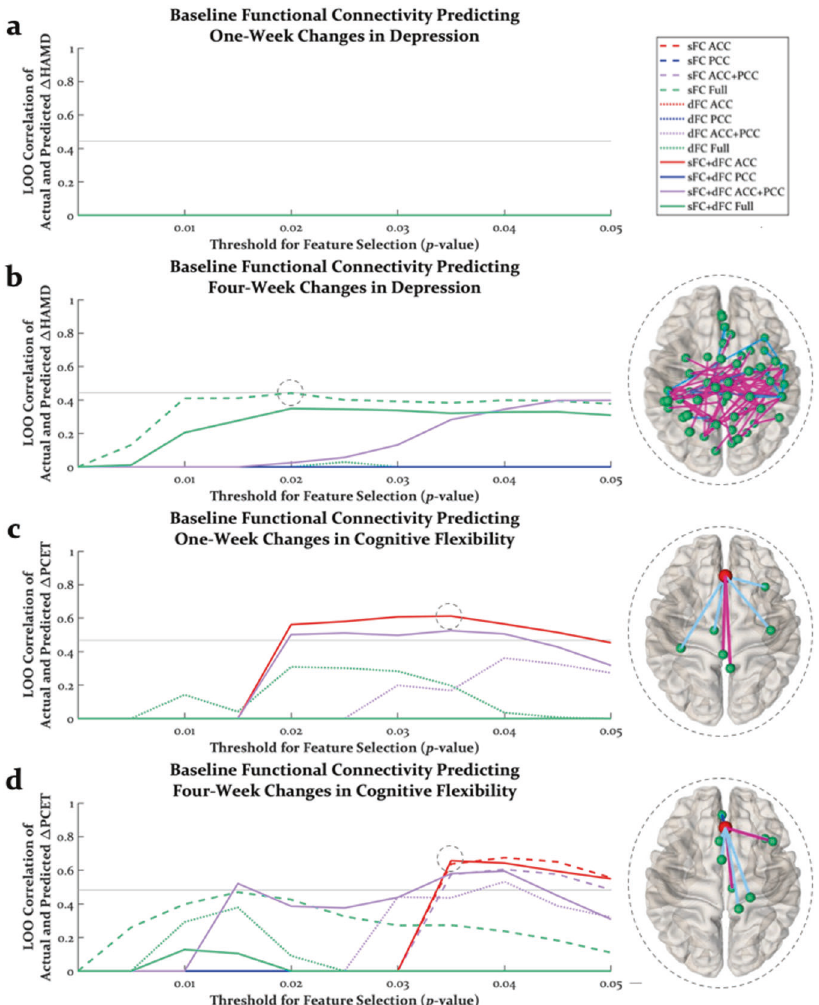
Fig. 4 Connectome-based predictive modeling of pre- to post-psilocybin therapy changes in depression and cognitive fl exibility. Performance of models trained on baseline functional connectivity as a function of the threshold for feature selection predicting 1-week ( a ) and 4-week ( b ) changes in depression ( Δ HAMD) and 1-week ( c ) and 4-week ( d ) changes in cognitive fl exibility ( Δ PCET). Horizontal gray lines indicate model performance at p = 0.05. Brains on the right side of panels are the best-performing models (see gray circles on performance lines). A brain was not plotted for predicting 1-week changes in depression, as there was no model was that performed at r > 0. Edges that were included in at least 75% of folds were plotted in dark blue, magenta, and light blue, representing sFC edges positively correlated with behavior, sFC edges negatively correlated behavior, and dFC edges positively correlated with behavior, respectively. Brain visualizations created with NeuroMArVL (https://immersive.erc.monash.edu/neuromarvl/). LOO leave-one-out, sFC static functional connectivity, dFC dynamics of functional connectivity, ACC anterior cingulate cortex, PCC posterior cingulate